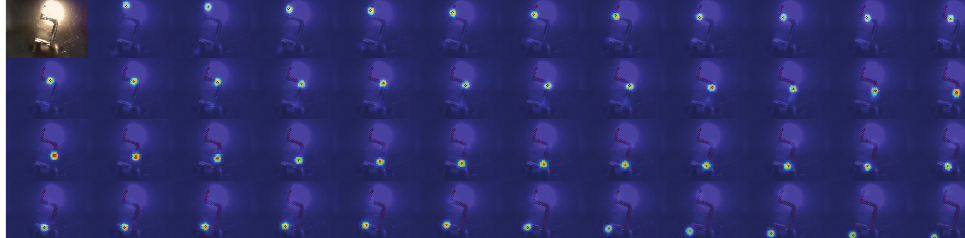
Figure 5. This figure illustrates the heatmap responses of the HRNet module. The upper left is the raw image, and the rest are heatmaps of each